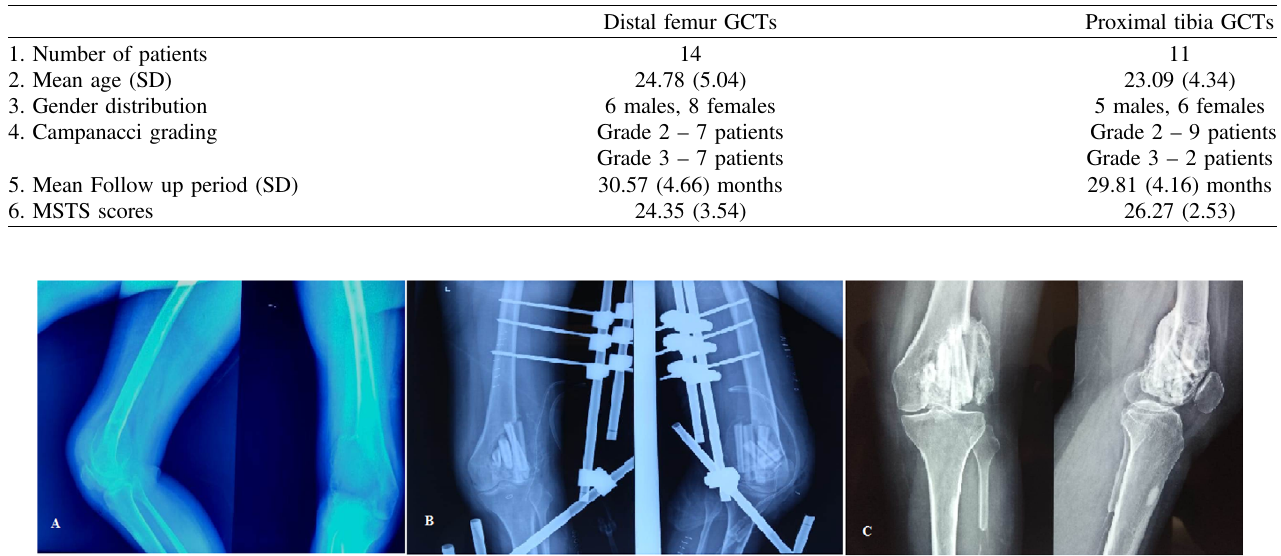
Table 2. Comparison between results of distal femur and proximal tibia GCTs.